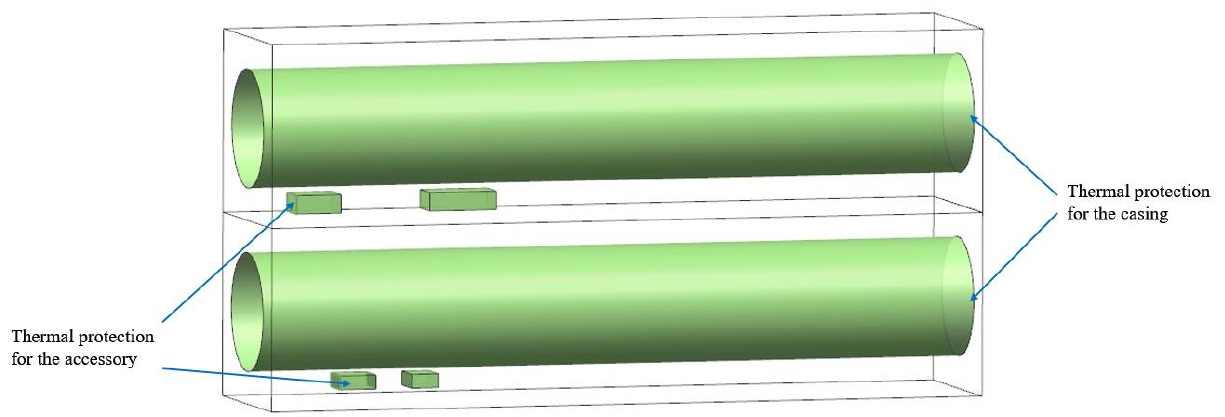
Figure 17. The diagram of the combined thermal protection for the casing and the accessory. The temperature change of accessory 1 over time in cases 5–8 is shown in Figure 18.